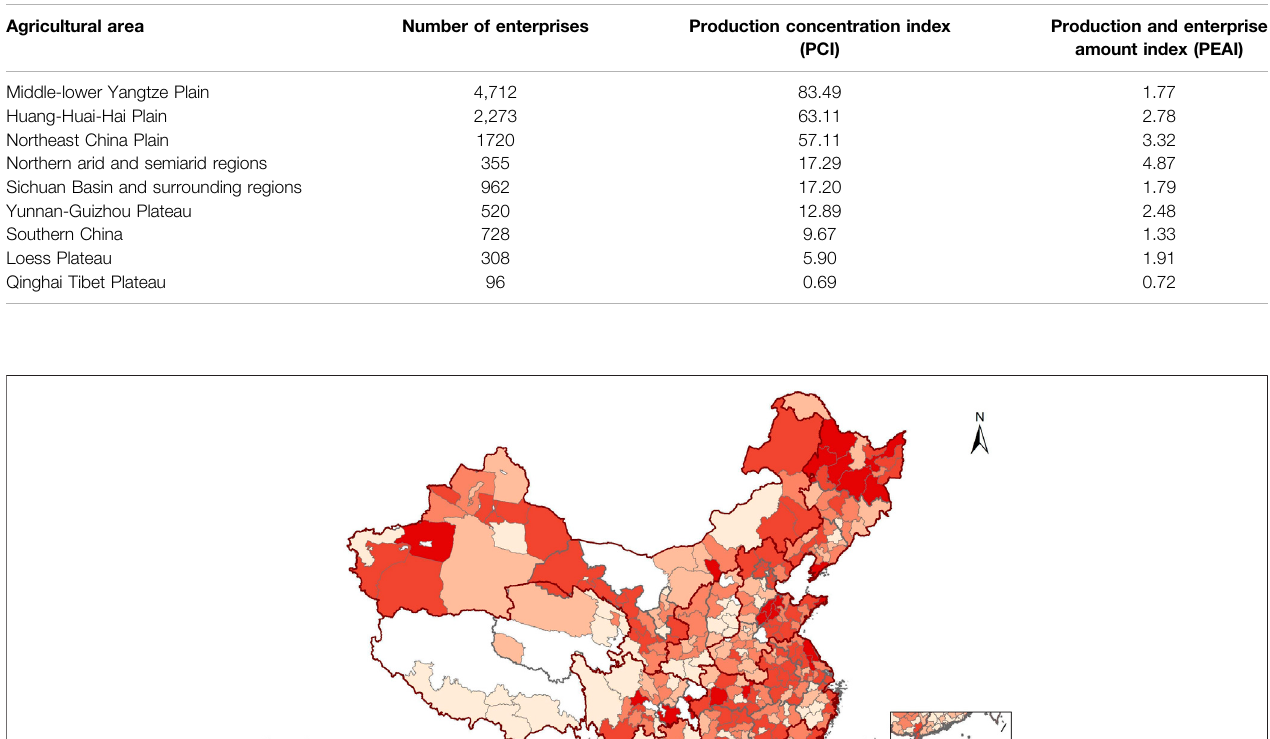
TABLE 2 | Production concentrations in different agriculture areas.